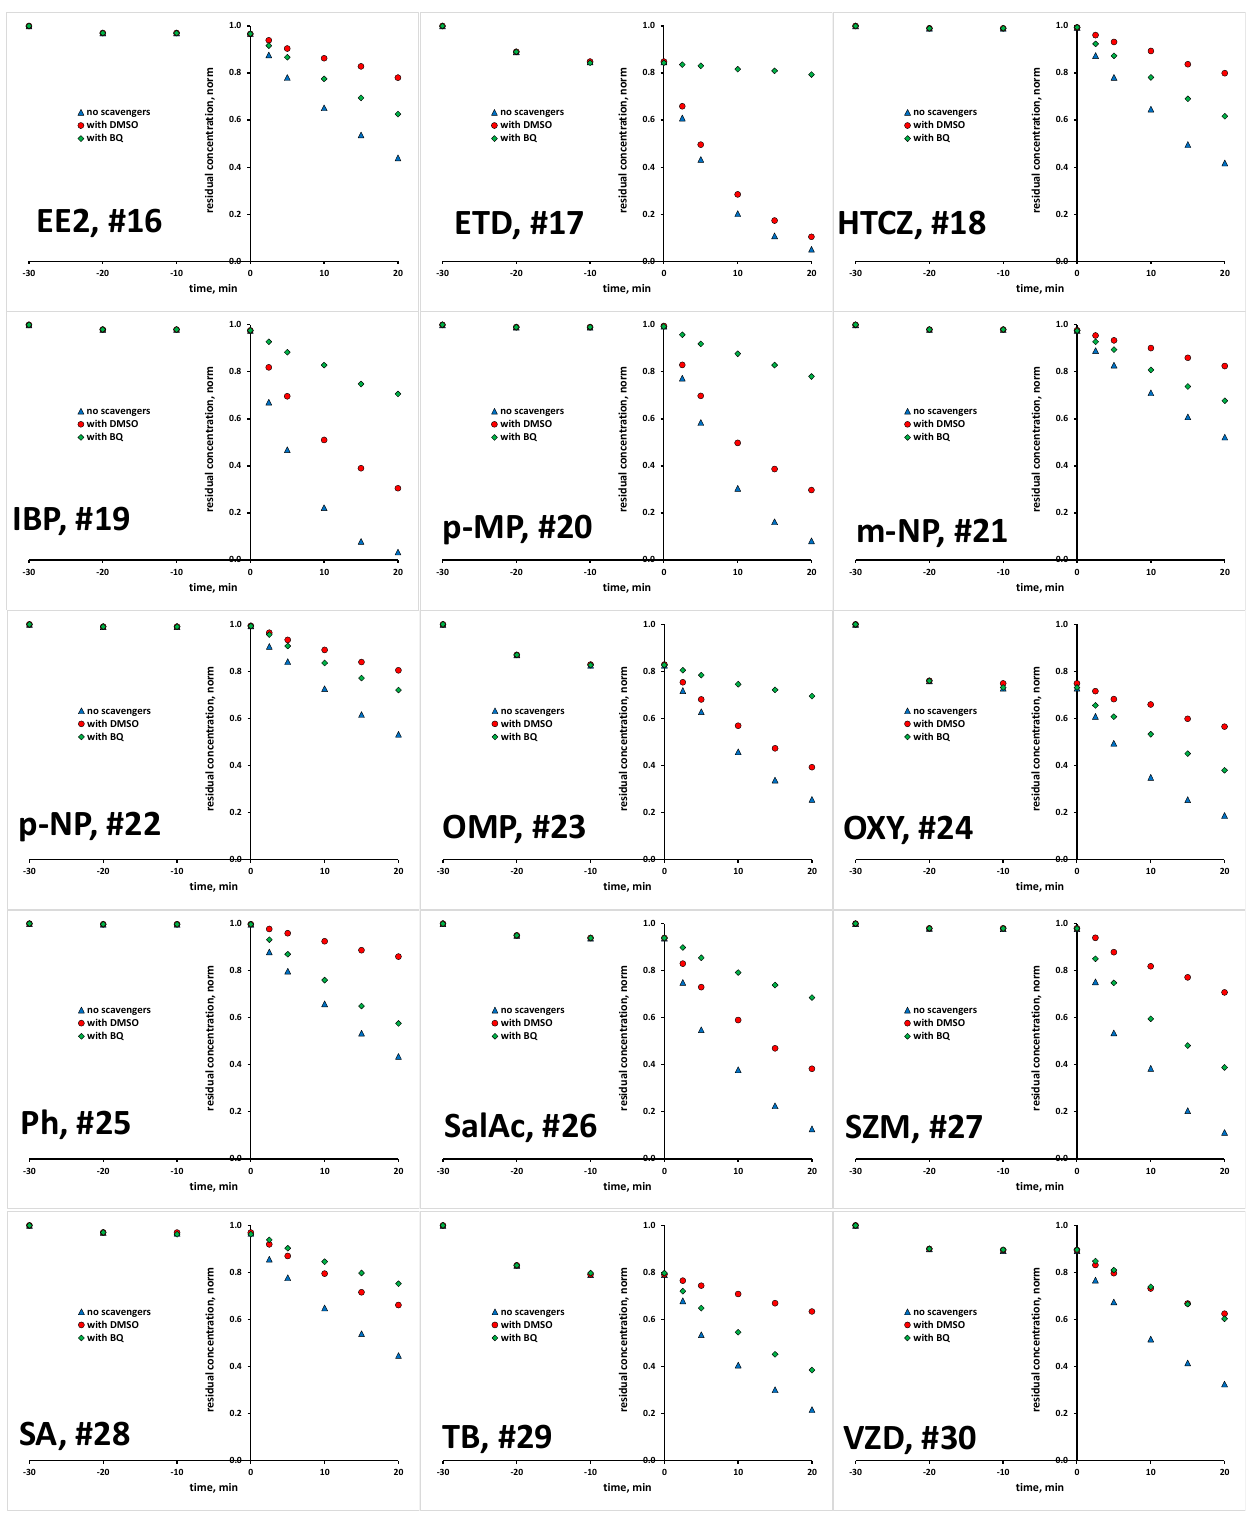
Figure 2. Degradation kinetics of studied organics (#16–30, Table 1) without and with the presence of scavengers for HO• and O 2 • − . These relative values were then brought into correlation by creating the K coefficient, which denotes ratio of organics degraded by HO• ( 𝑀 (Equation (6)).